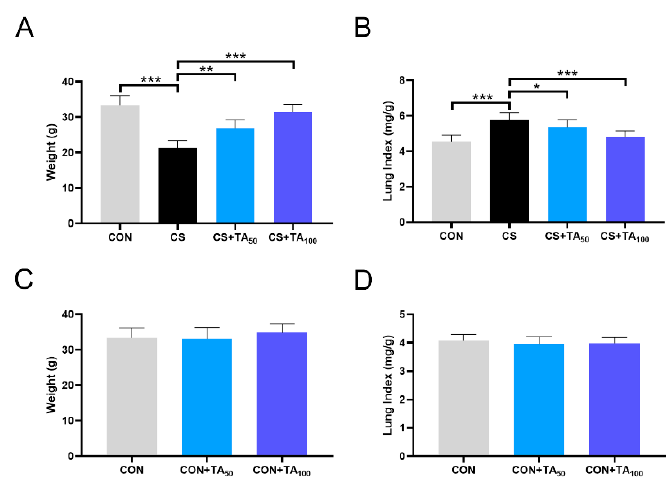
Figure 2. Effects of TA on ( A ) body weight and ( B ) lung index in normal mice (CON) and cigarette smoking (CS)-exposed mice treated with 50 and 100 mg/kg TA. Effects of TA on ( C ) body weight and ( D ) lung index in normal mice exposed to fresh air. * P < 0.05, ** P < 0.01, *** P <